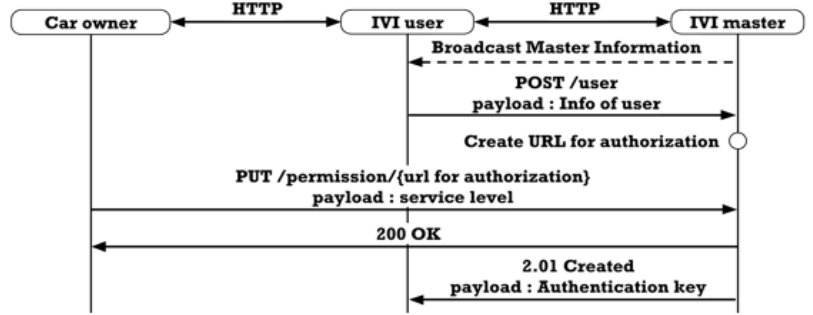
Figure 9. Operation flows for IVI user registration .